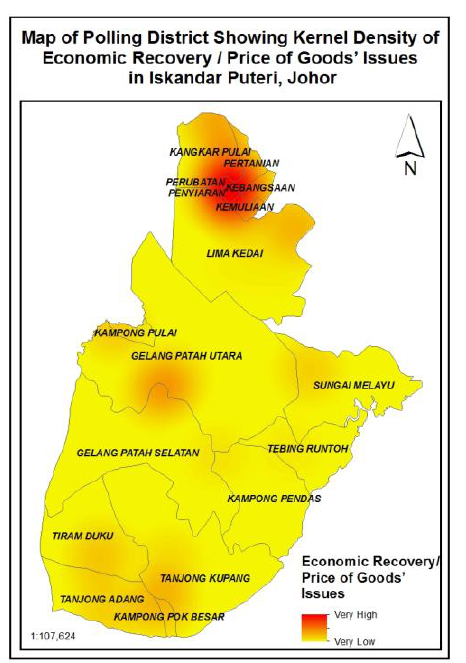
Figure 11. Result of the hot spot maps using KDA for economic recovery and price of goods‟